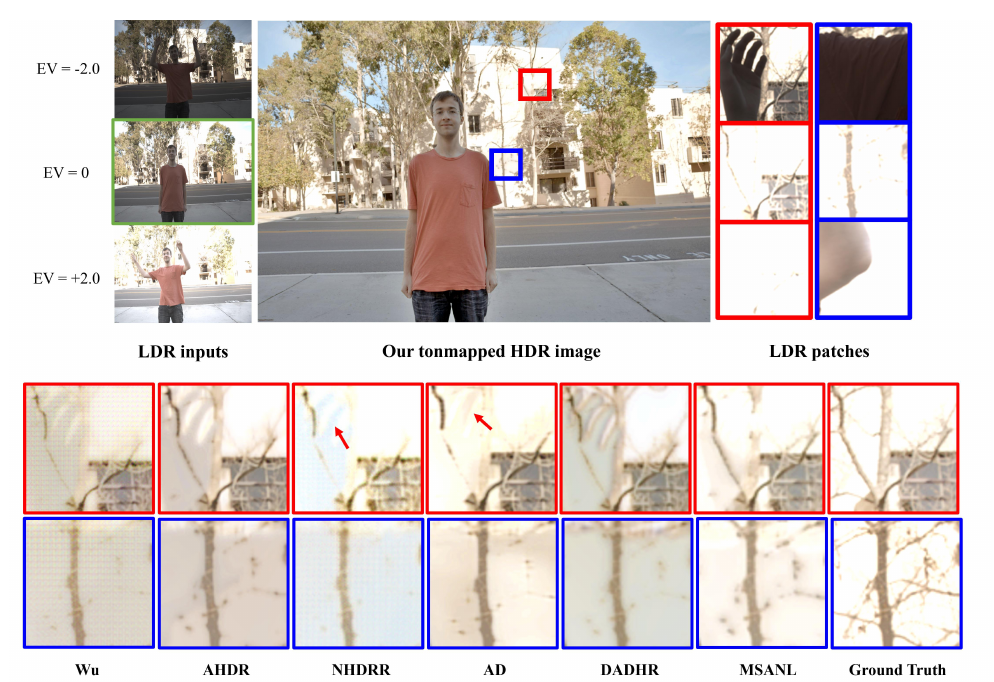
Figure 7. Qualitative comparison of HDR result images of the proposed method (MSANLnet) and state-of-the-art models. From left, Wu [28], AHDR [26], AD [27], NHDRR [30], DAHDR [39], Proposed MSANLnet, and Ground